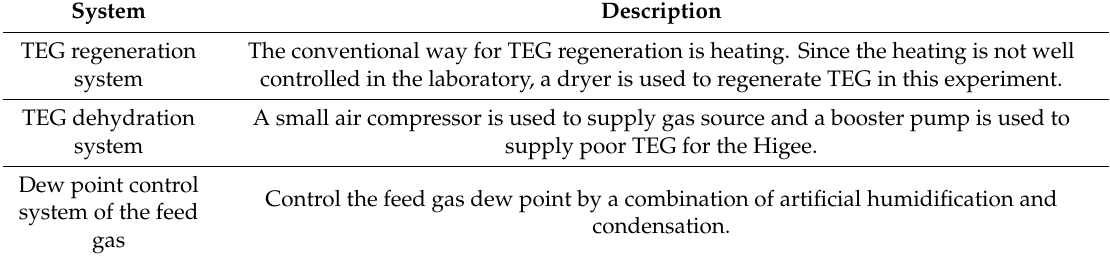
Figure 4. Experiment flow chart. Table 2. Description of each system.